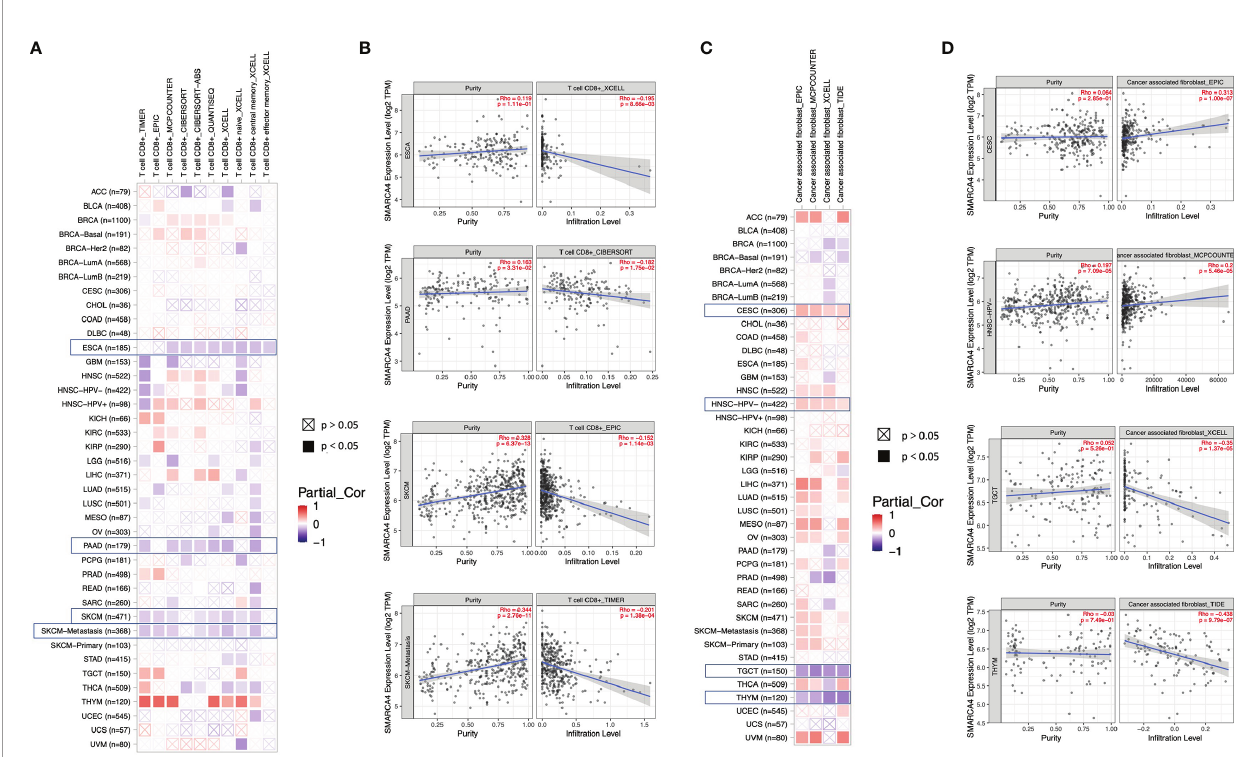
FIGURE 6 | Correlation analysis between SMARCA4 expression and immune in fi ltration of CD8+ T cell and cancer-associated fi broblasts base on analysis of 22 immune cell types. Different algorithms were used to explore the potential correlation between the expression level of the SMARCA4 gene and the in fi ltration level of (A, B) CD8+ T cell and (C, D) cancer-associated fi broblasts across all types of cancer in